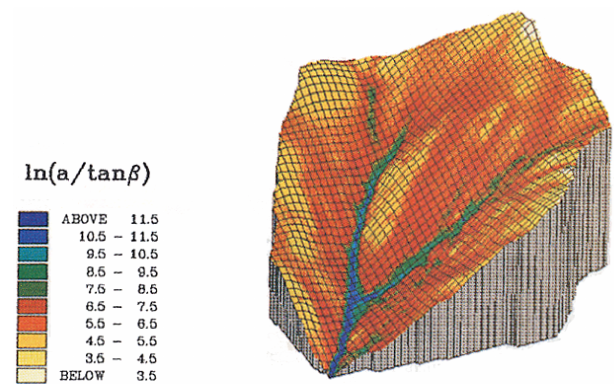
Figure 6. Pattern of topographic index for the Ringelbach catch- ment, Vosges, France, superimposed on a digital terrain model (after Ambroise et al., 1996b, with permission from the American Geo- physical Union). The highest values in the valley bottom and con- vergent hollows will be predicted as saturating first. A small spring in the catchment on the right-hand hillslope, indicating subsurface convergence, is not reflected in the pattern of the index shown on this map since this is based on the topographic flow pathways